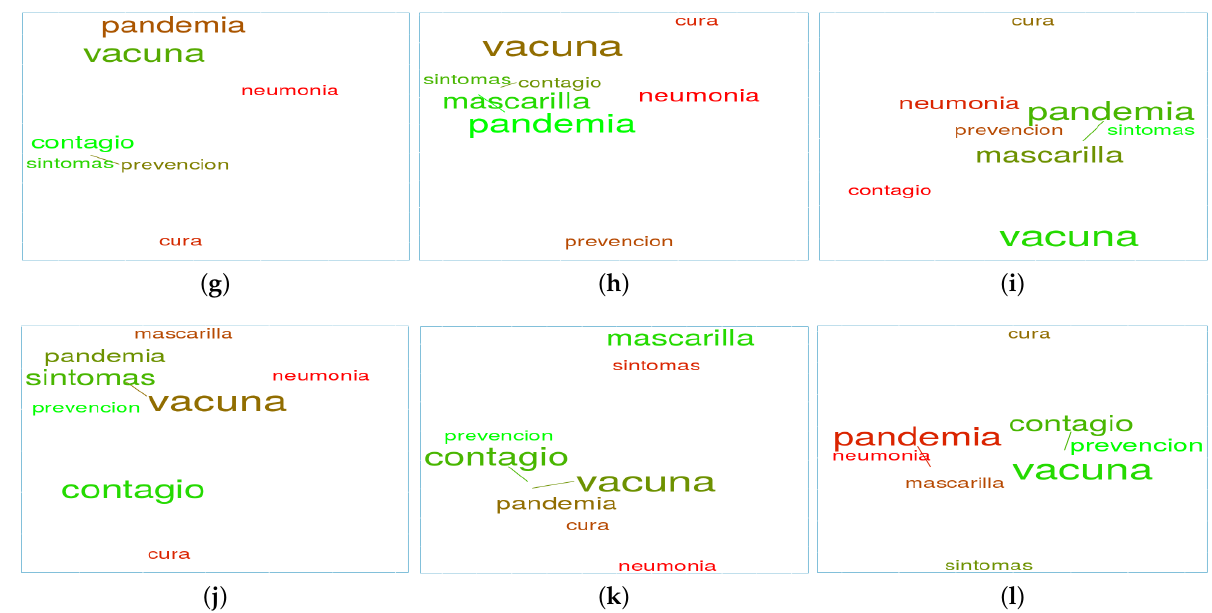
Figure 6. Sentiment evolution of vaccines topic in the different countries: ( a ) Chile, March 2020; ( b ) Chile, Sept. 2020; ( c ) Chile, March 2021; ( d ) Mexico, March 2020; ( e ) Mexico, Sept. 2020; ( f ) Mexico, March 2021; ( g ) Peru, March 2020 ( h )